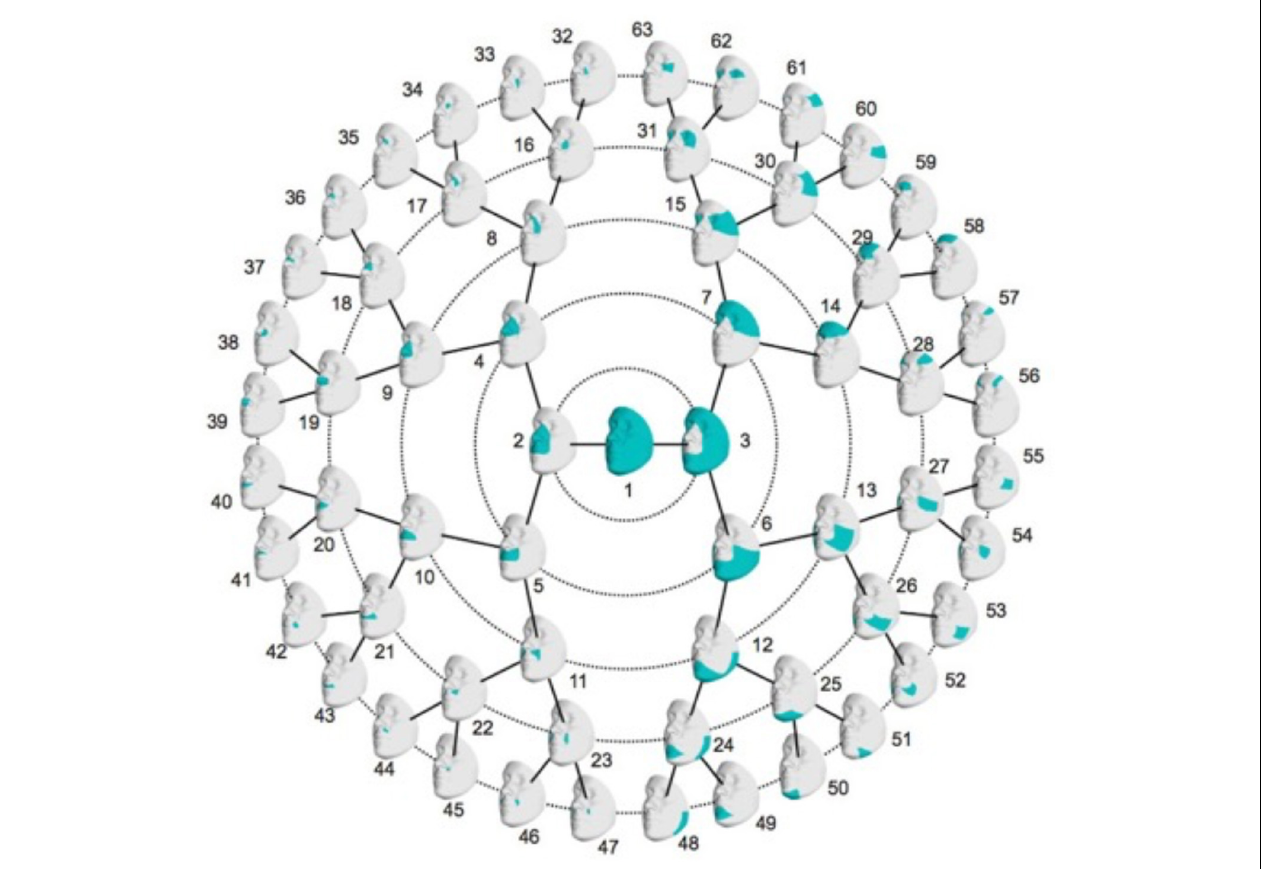
FIGURE 1 | Rosette diagram showing the hierarchical global-to-local facial segmentation scheme. A total of 63 facial modules are represented. Modules are indicated in